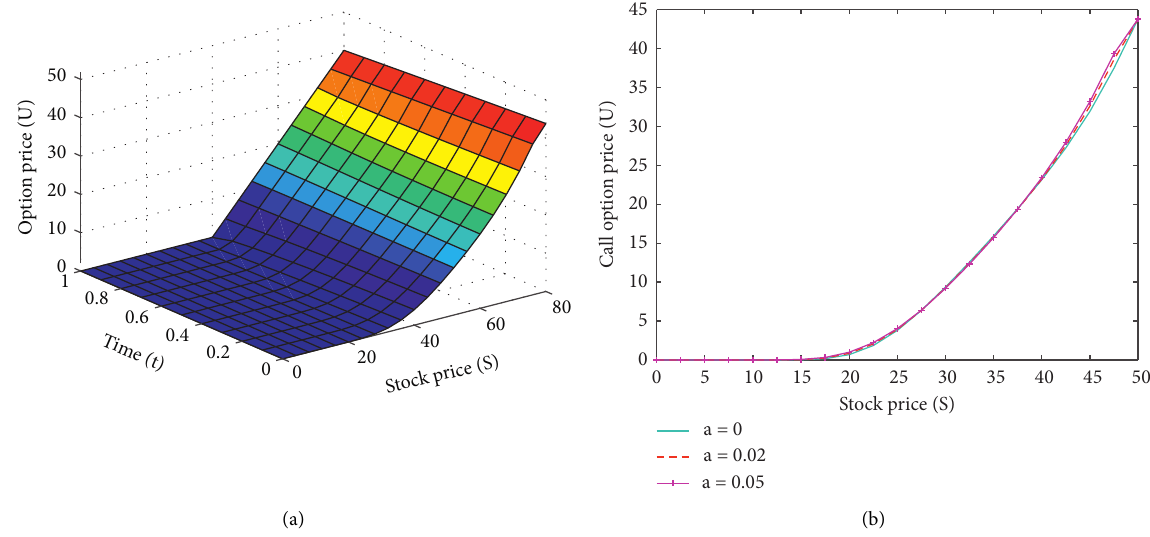
Figure 1: (a) European call option price charts of the explicit nonstandard method for a � 0 . 05 and (b) European option price charts of the explicit nonstandard method for different transaction costs in t � 0.